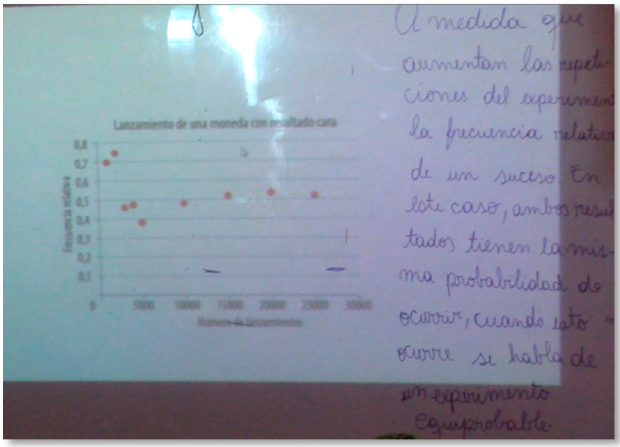
Figure 12. Image capture of 6th grade class.